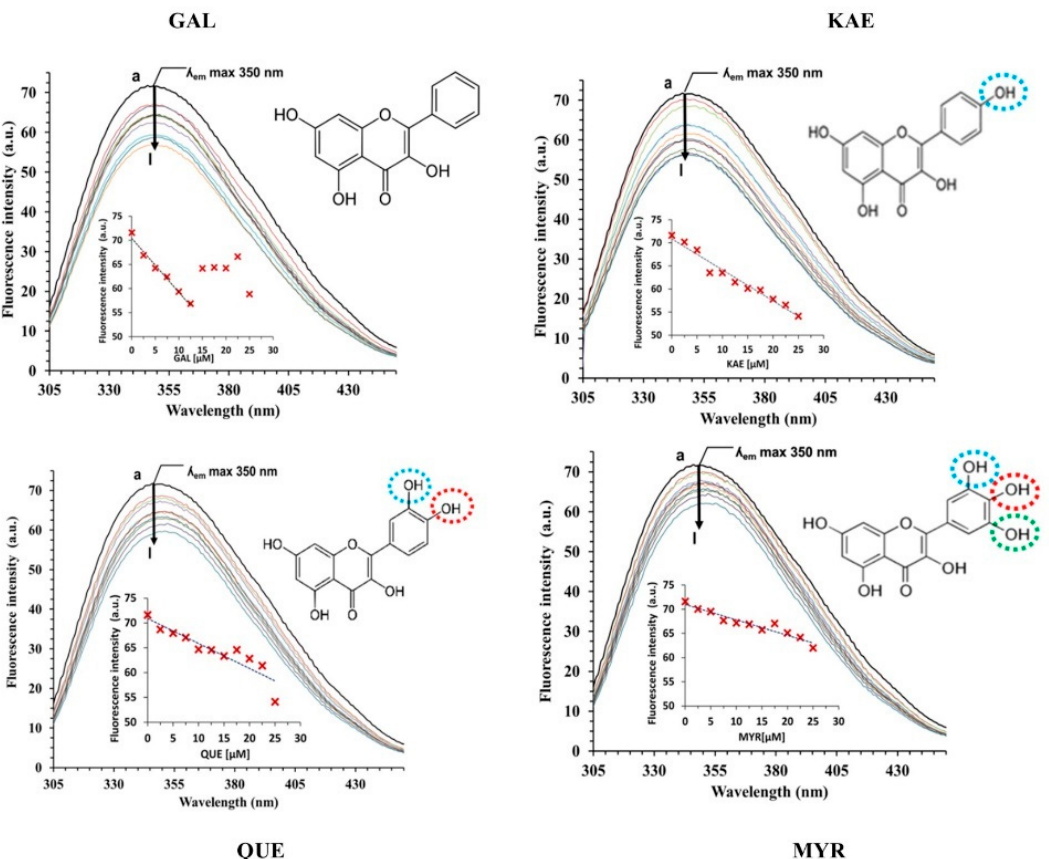
Figure 3. Fluorescence emission spectra of CpLIP2 lipase alone or with increasing concentrations of single flavonols (coloured lignes). The concentration of CpLIP2 was 2.5 µM, and the final concentrations of flavonols correspond to the following gradient from a to l (see arrow): 0, 2.5, 5.0, 7.5, 10.0, 12.5, 15.0,17.5, 20.0, 22.5 and 25 µM of GAL (galangin), KAE (kaempferol), QUE (quercetin), and MYR (myricetin). Measurements at 293 K, pH: 7.0, 300 mM NaCl; EtOH 0.1%. The excitation wavelength was 285 nm, and the emission spectra was recorded in the wavelength range of 305–450 nm. Increment slits 1 nm. Corrections of inner filter was applied to all spectra. The four insert plots represent the fluorescence intensities at ʎ em = 350 nm as a function of quencher concentrations.